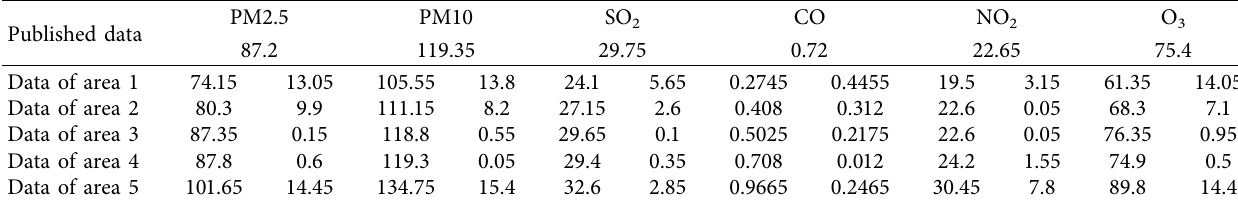
Table 2: Comparison of task grid data and published